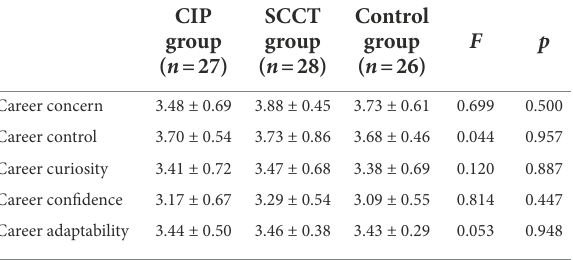
TABLE 1 Pre-test of career adaptability scores among three